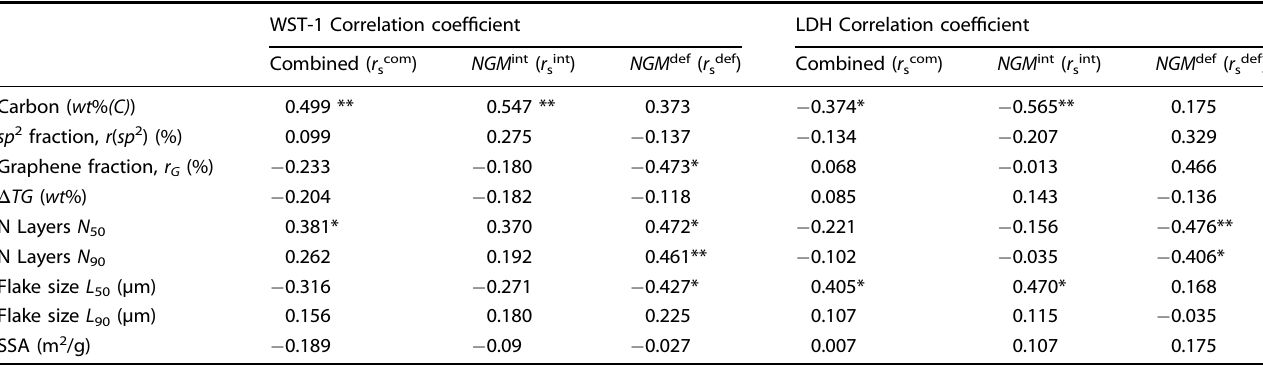
Table 1. Spearman ’ s correlation coef fi cients: combined ( r scom ), for NGM int ( r sint ) and for NGM def ( r sdef